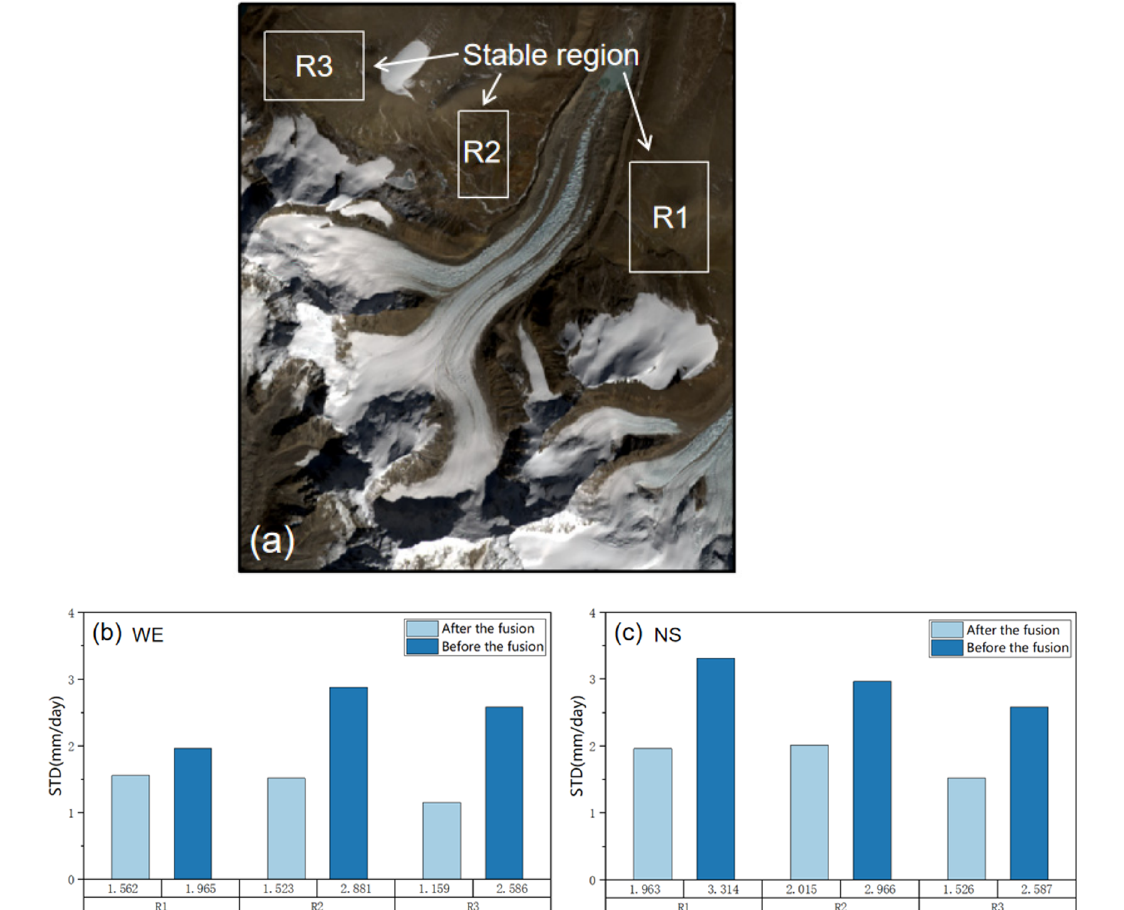
Figure 10. Monitoring accuracy before and after fusion: ( a ) stable regions R1, R2, and R3 for accuracy assessment; ( b ) standard deviation comparison in the west–east stable region; ( c ) standard deviation comparison in the north–south stable region.